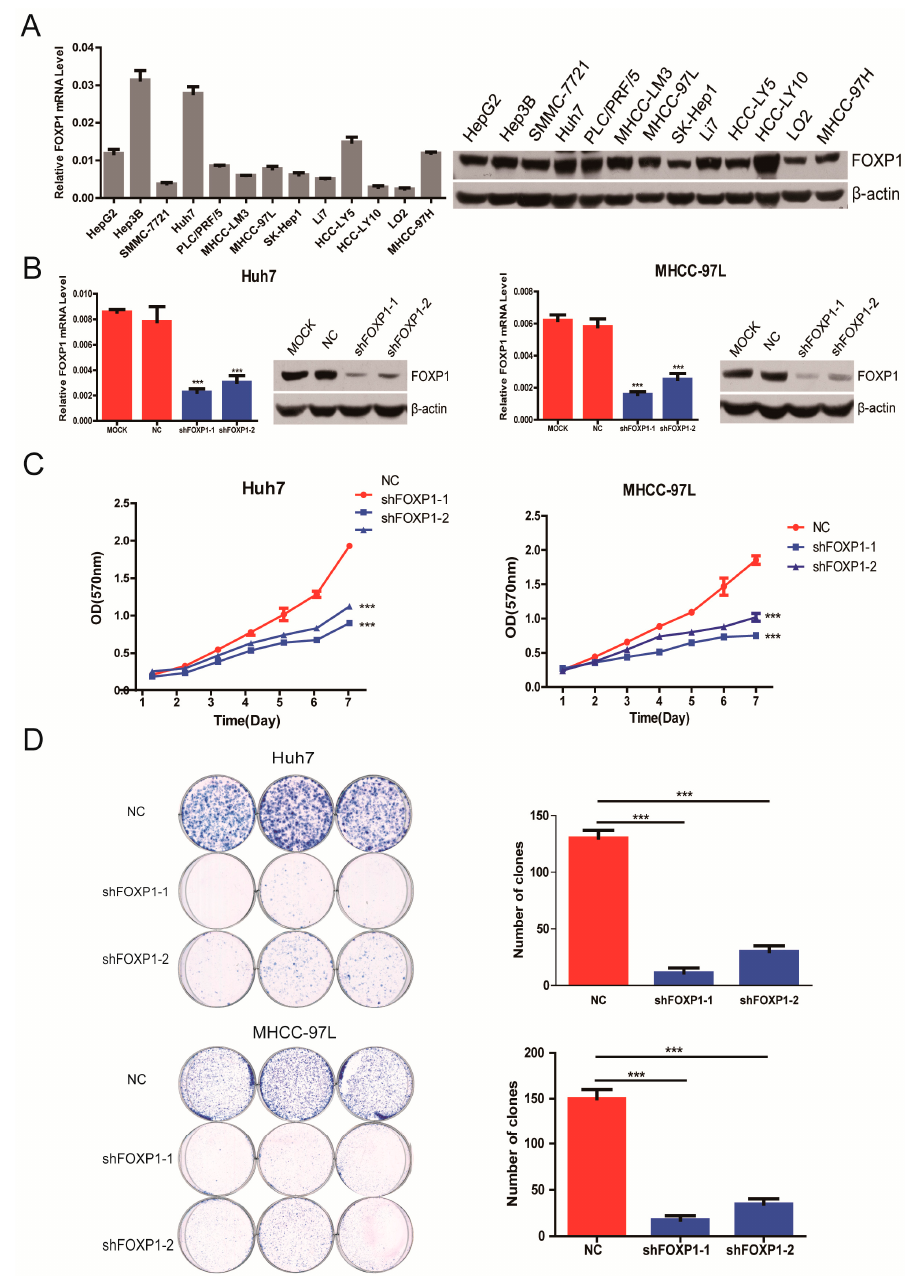
Figure 2. The effect of FOXP1 on the growth ability of HCC cells in vitro. ( A ) FOXP1 mRNA and protein levels in the HCC cell lines; ( B ) FOXP1 mRNA and protein levels in Huh7 and MHCC-97L cells stably transfected with shFOXP1, the scrambled sequence control cells (NC) and untreated cells (MOCK); ( C ) MTT assays for Huh7 and MHCC-97L cells that were stably transfected with either shFOXP1 or NC. *** p < 0.001; ( D ) Colony formation assays for Huh7 and MHCC-97L cells that were stably transfected with shFOXP1 or a scrambled sequence control. *** p < 0.001.